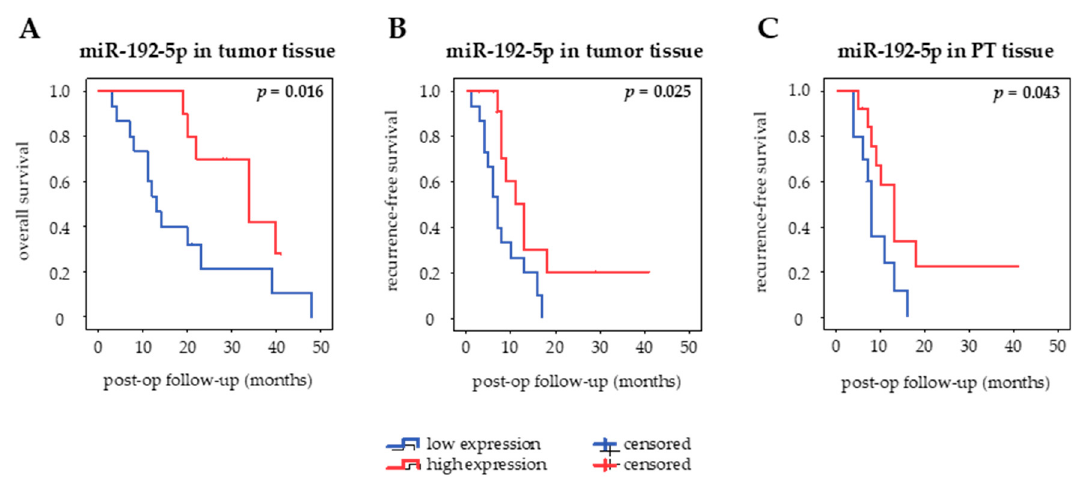
Figure 5. Kaplan–Meier curves. Prognostic impact of tissue-derived miR-192-5p on ( A ) overall survival and ( B ) recurrence-free survival and of ( C ) peritumoral tissue-derived miR-192-5p on recurrence-free survival in curatively resected patients. Bold values indicate statistical significance ( p ≤ 0.05, log-rank test).